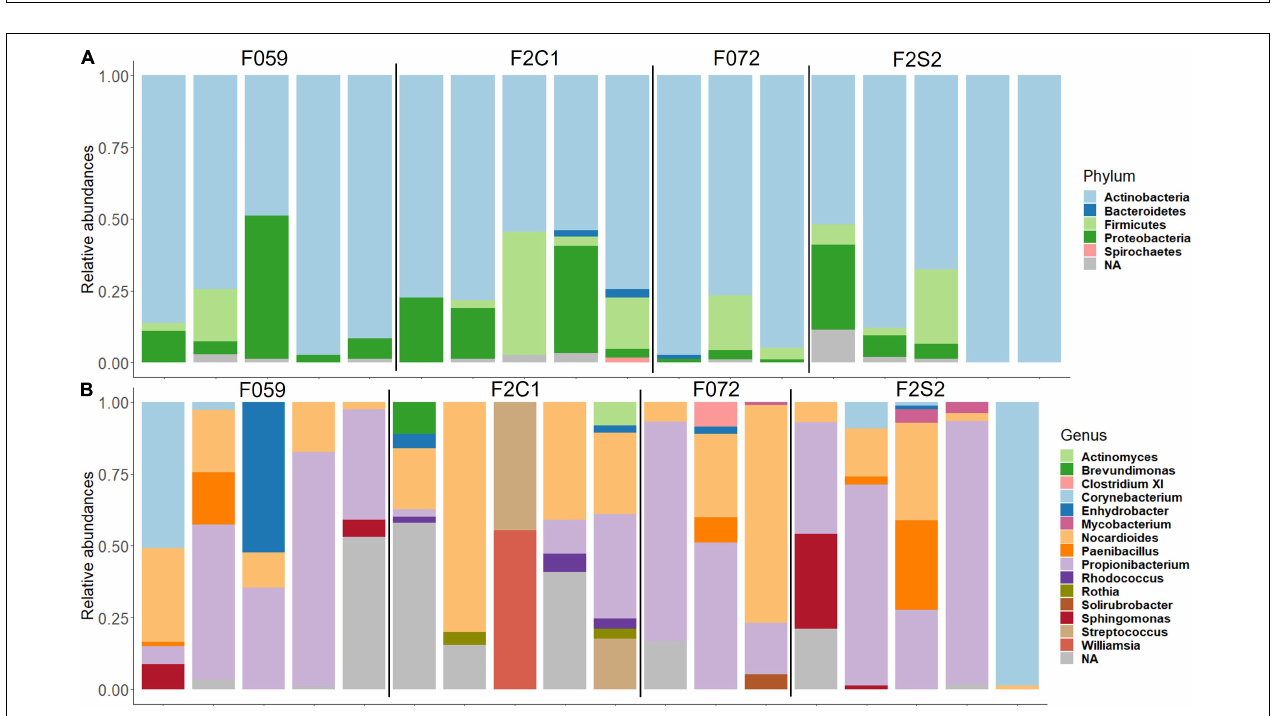
FIGURE 3 | Relative abundance of bacteria found in the buccal cavity mucus of Nile tilapia bred in captivity. (A) Phylum level. (B) Genus level. F0 generation: F059, F072 and F2 generation: F2C1, F2S2.